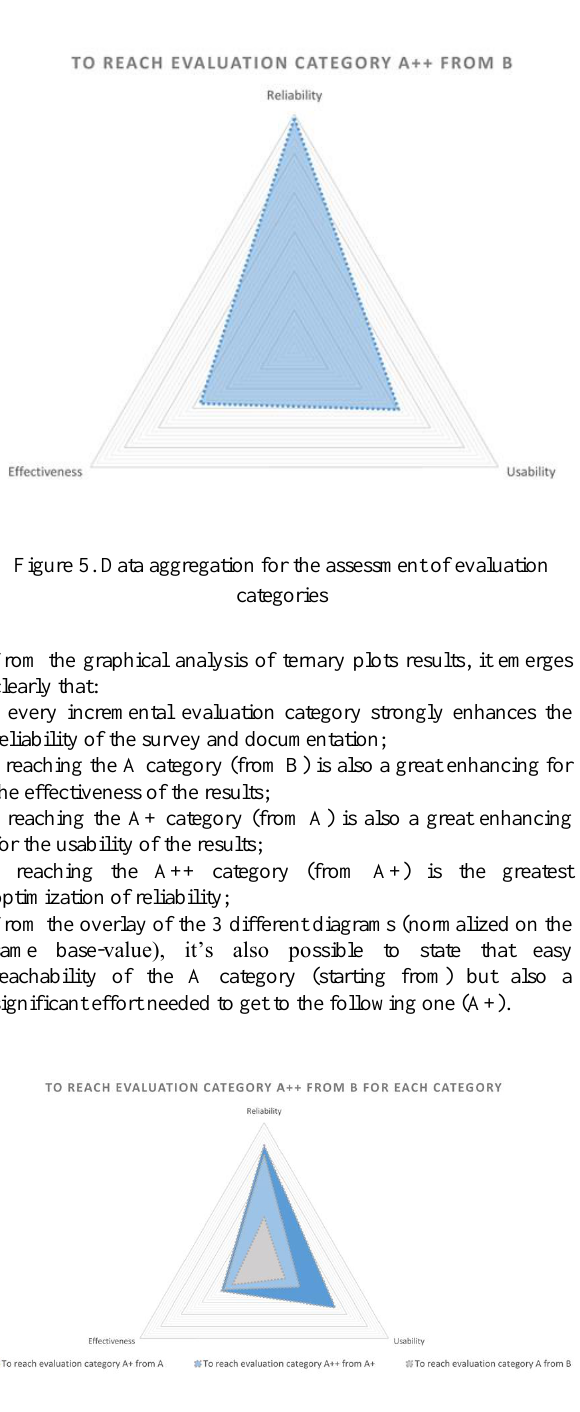
Figure 6. Data aggregation for each